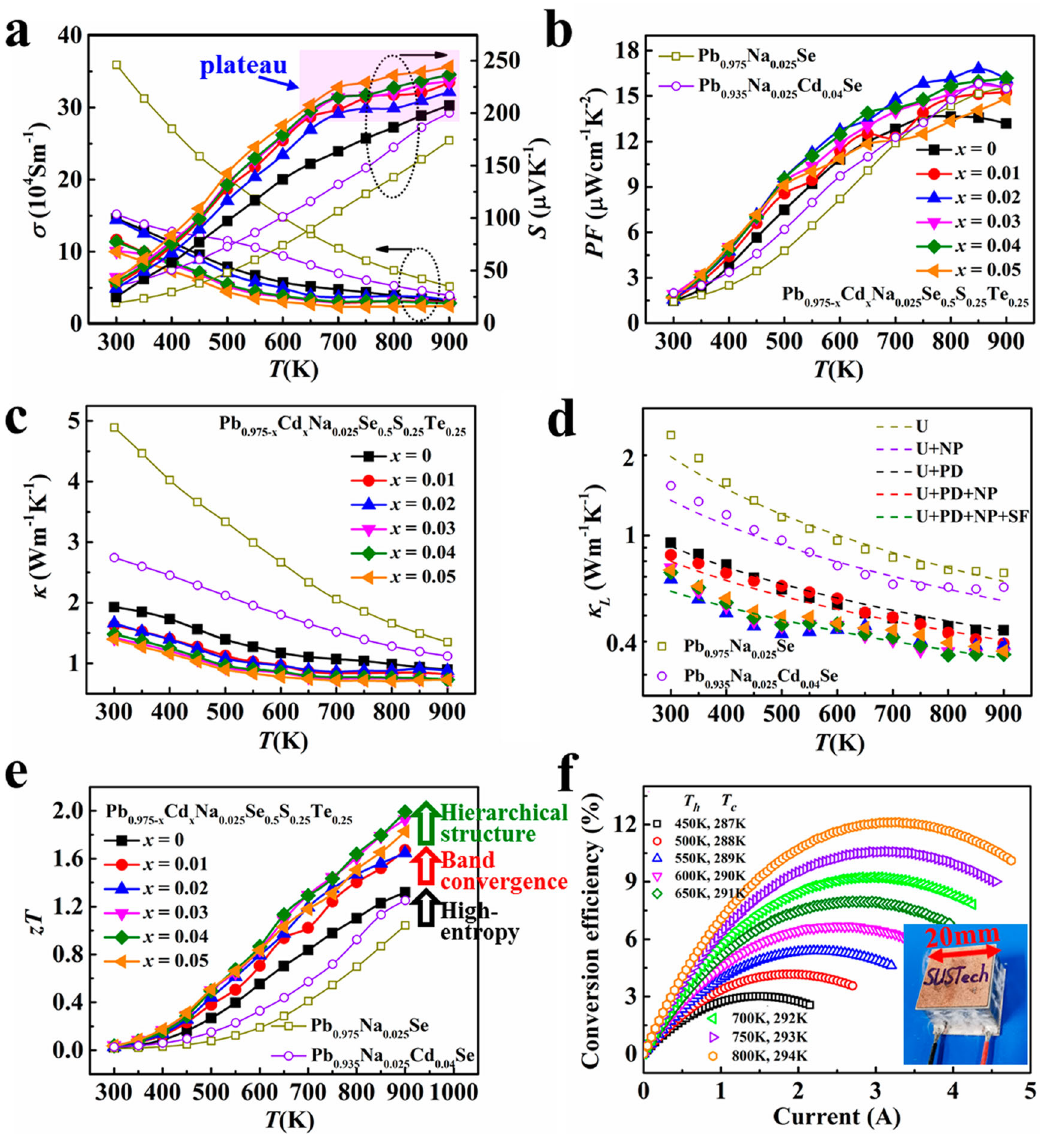
Fig. 3 TE performance of chalcogenide-based materials and modules. Temperature dependences of a electrical conductivity σ (the left black arrow), the Seebeck coef fi cient S (the right black arrow), b power factor PF , c total thermal conductivity κ , d lattice thermal conductivity κ L , and e zT values of Pb 0.975 Na 0.025 Se, Pb 0.935 Na 0.025 Cd 0.04 Se, and Pb 0.975 − x Cd x Na 0.025 Se 0.5 S 0.25 Te 0.25 ( x = 0, 0.01, 0.02, 0.03, 0.04, 0.05) samples. The dash lines in e were calculated by the modi fi ed Debye – Callaway model. U, NP, PD, and SF represent Umklapp process, nanoprecipitates, point defects, and stacking faults scattering for phonons, respectively. f Current dependence of conversion ef fi ciency under different operating temperatures ( T h , temperature at hot side; T c , temperature at cold side) for the fabricated segmented TE module (the inset